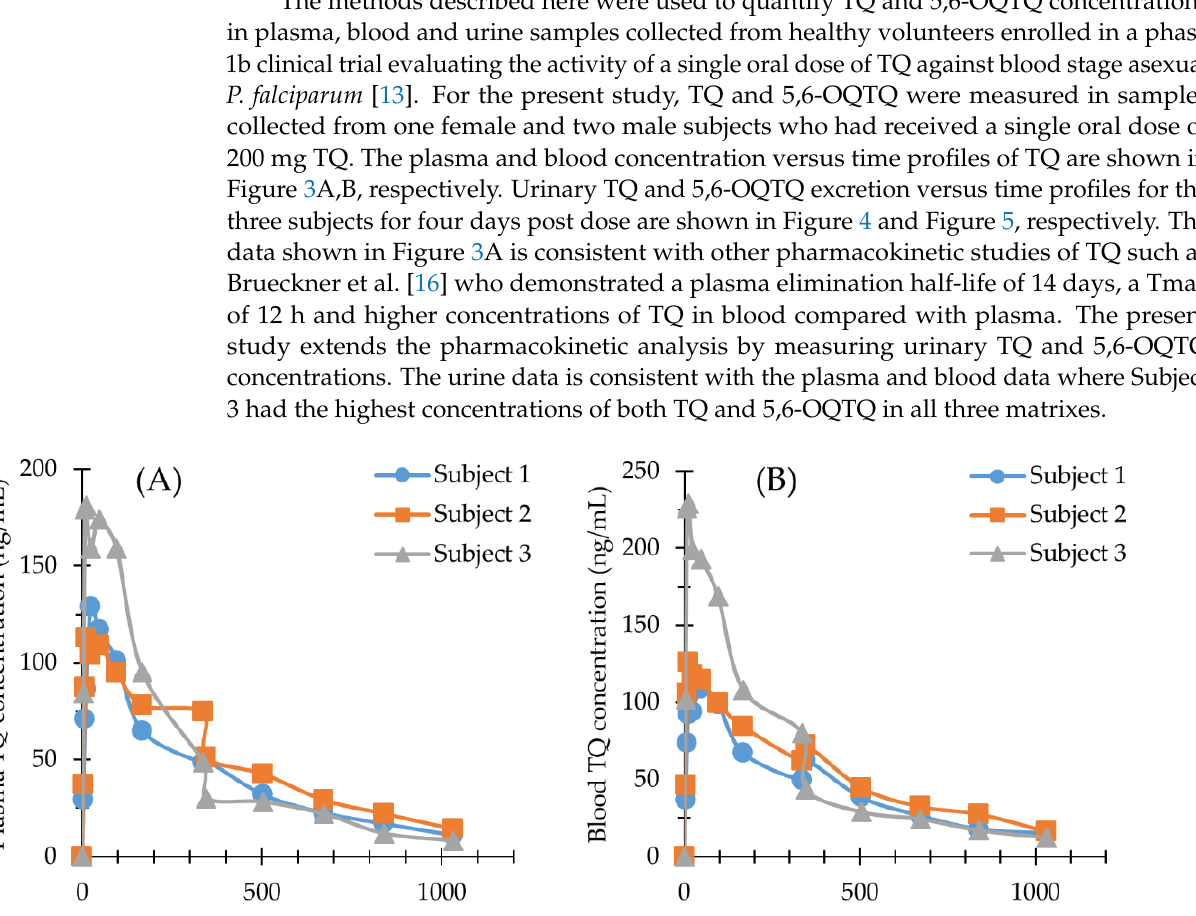
Figure 4. TQ in human urine ( n = 3). ( A ) The amount of TQ excreted (AE) versus time profile; ( B ) The cumulative amount of TQ excreted (CAE) versus time profile. Time was the endpoint of each 24 h urinary collection period. Figure 5. 5,6-OQTQ in human urine ( n = 3). ( A ) AE versus time profile; ( B ) CAE versus time profile. Time was the endpoint of each 24 h urinary collection period.